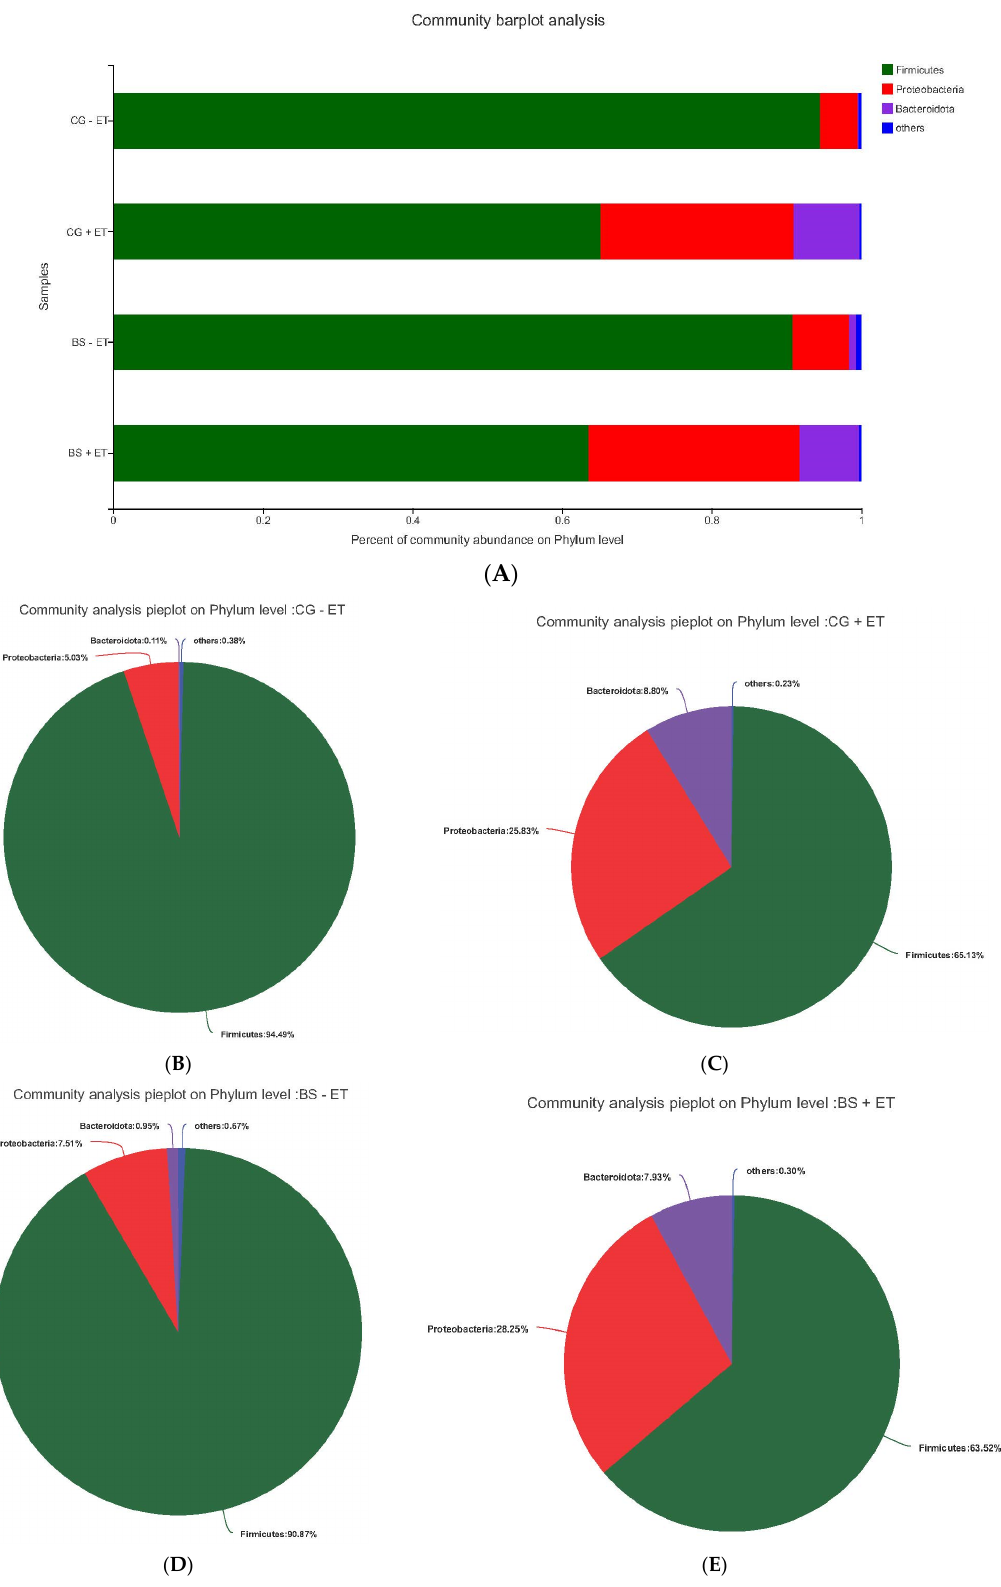
Figure 3. Relative abundances of the taxa at phylum level. ( A ) Relative abundances of the affected taxa at phylum level among all groups. ( B ) Total affected percentage of each phylum in group CG − ET. ( C ) Total affected percentage of each phylum in group CG + ET. ( D ) Total affected percentage of each phylum in group BS − ET. ( E ) Total affected percentage of each phylum in group BS + ET.